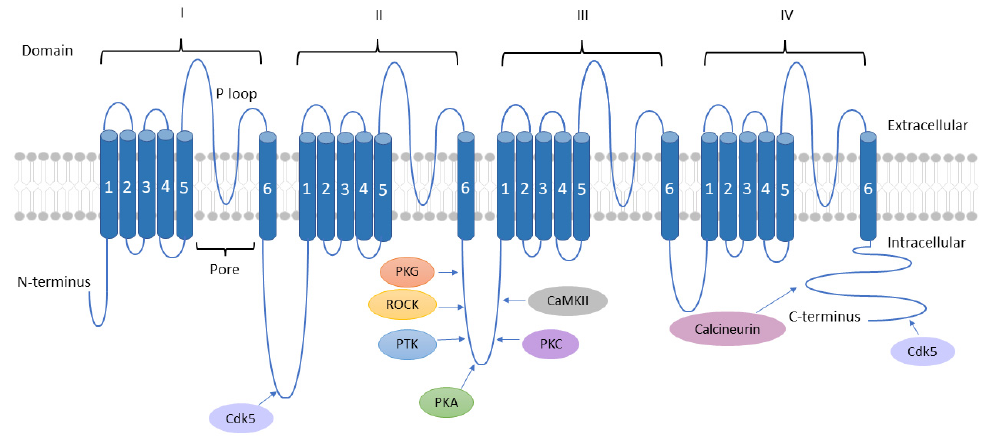
Figure 2. Schematic representation of Cav3 pore-forming subunit showing interaction sites of different kinases and phosphatases. Each of the four domains have transmembrane segments labelled from 1-6. Target residues of PTK, PKG, ROCK, and PKC are not yet identified; however, they are found to be associated with the II-III loop region of the Cav3 channel. PKA phosphorylates ser1107 residue of Cav3.2, while its interaction with other isoforms is not yet known. Ser 1198 of Cav3.2 acts as a modulatory site for CaMKII. Cdk5 interacts with both Cav3.1 (ser 2234 in the C-terminus) and Cav3.2 (ser 561 (I-II loop) & ser 1987 in the C-terminus). Calcineurin recognizes PCISVE (2190–2195) & LTVP (2261–2264) motifs in the C-terminus. Table 1. Major location of T-type Ca 2+